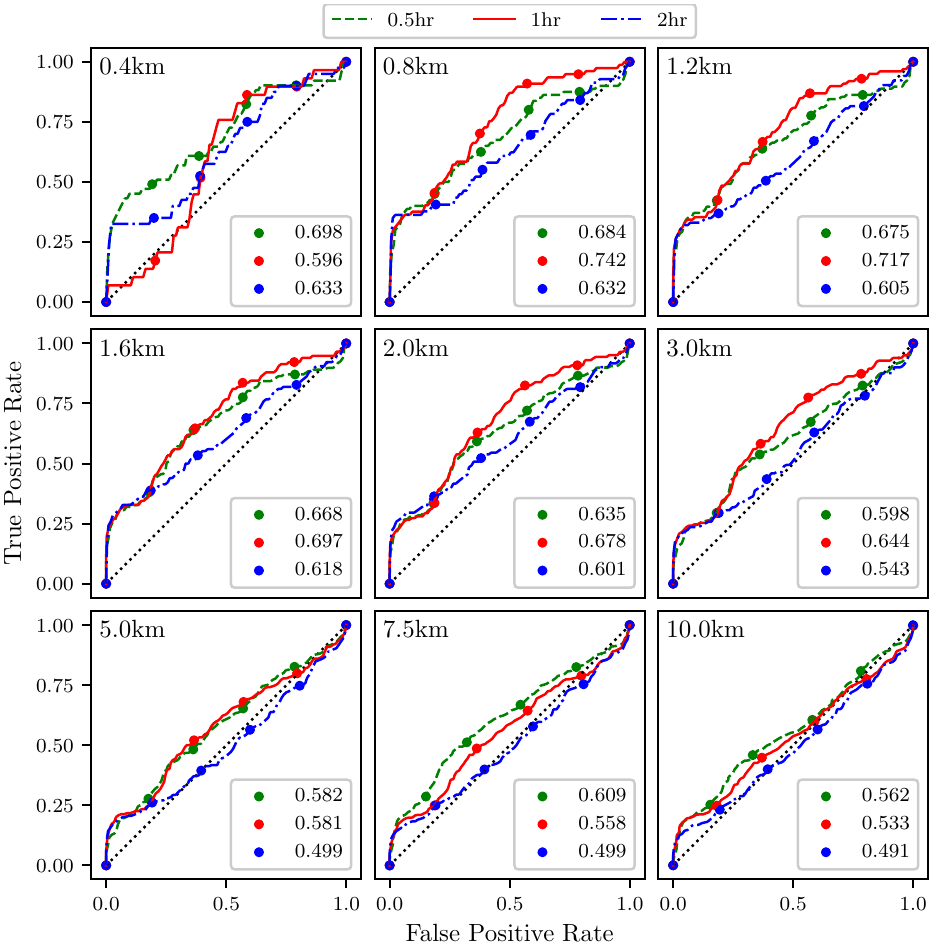
Figure 15. ROC curves for the trajectory divergence rate, ˙ ρ , as measured from a 2 km radius UAS simulation ability to detect 90th percentile LCSs with integration times of 0.5 ( green ), 1 ( red ), and 2 ( blue ) h. The threshold radius for each subplot is displayed in the upper left hand corner. The AUC for each integration time is given in the legend.